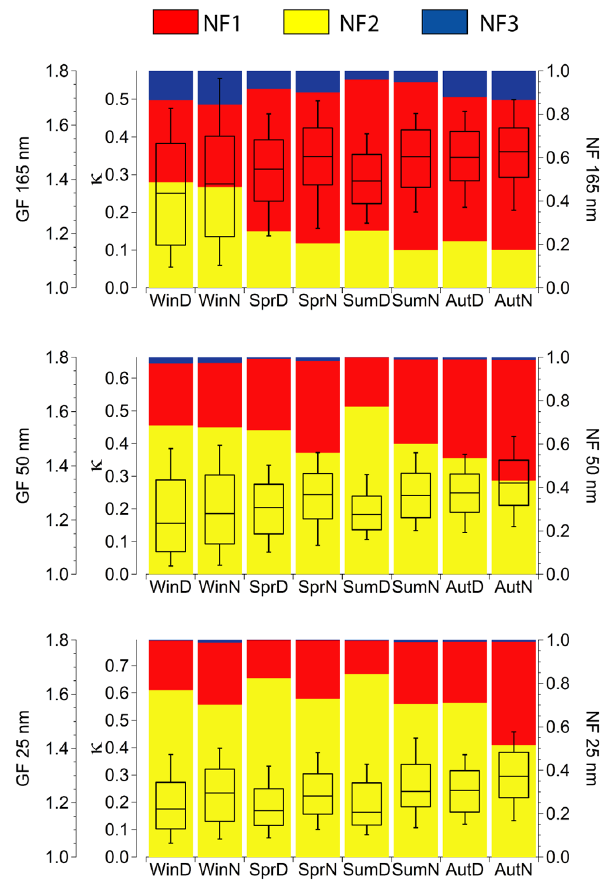
Figure 7. Diurnal and seasonal variations in hygroscopic growth factor (GF), kappa value ( κ) and number fractions (NF) measured at RH90 for particles in the nucleation mode (top panel), Aitken mode (middle panel) and accumulation mode (bottom panel). The figure shows the median GF value, with the bottom and top sides of the box giving the 25th and 75th percentiles, and the extremities the 10th and 90th percentiles. The coloured bars illustrate the NF of particles found in each hygroscopic mode. Table 5. Frequency of external mixing split by air mass